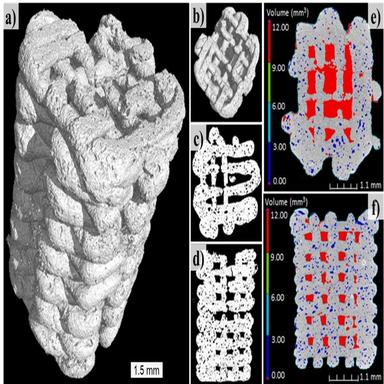
Three-dimensional (3D) virtual rendering for a representative 3D-lattice sample obtained by µ-CT. a) overview of the sample, b) top surface, c) transverse cross-section, d) longitudinal cross-section, e) and f) pore volume distribution in color scale.